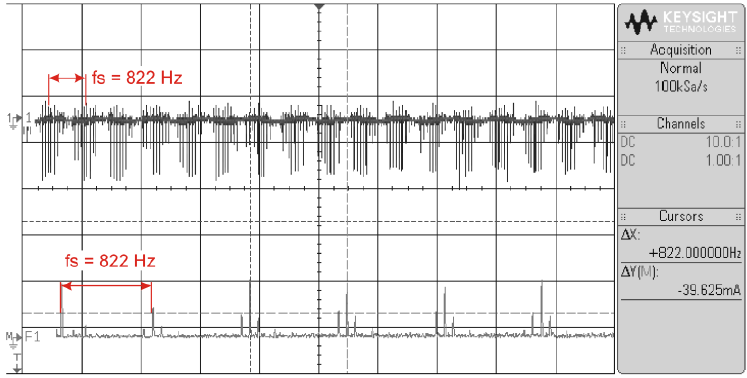
Figure 5. Characteristics of burst signal produced by power electronics.